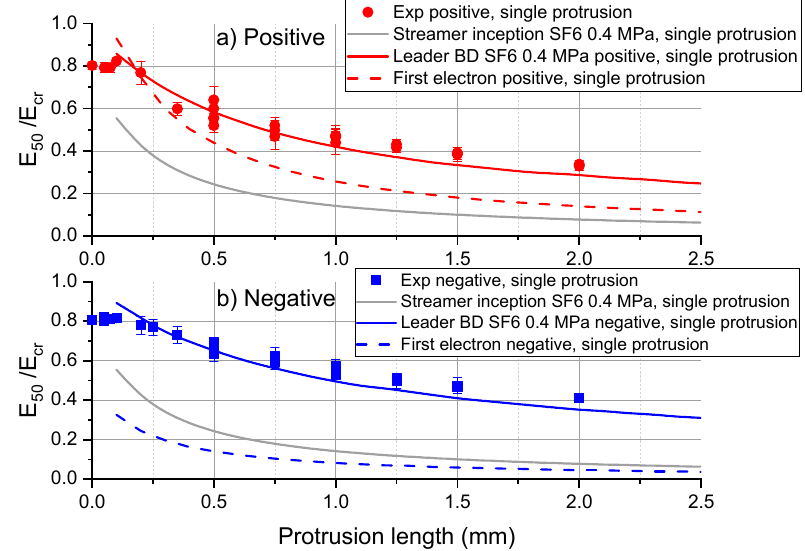
Figure 6. Normalized breakdown fields E 50 / E cr vs. protrusion length L for SF 6 and single protrusion at 0.4 MPa at ( a ) positive and ( b ) negative polarities.